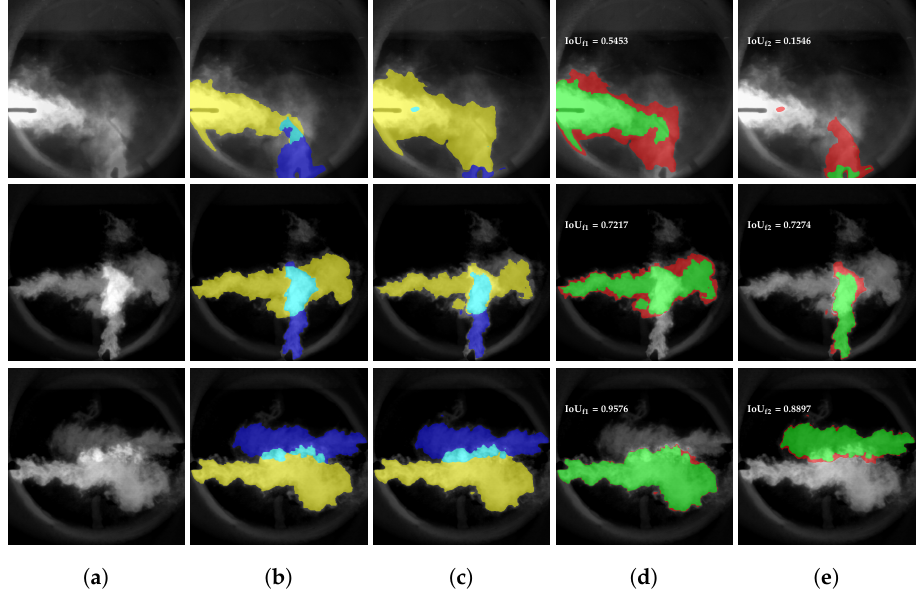
Figure 6. Gallery of instance flame segmentation with CNNs. From top to bottom, the figure shows different image series with increasing IoU f scores at our evaluation. ( a ) An original image example in our test data set. ( b ) The corresponding ground truth and ( c ) segmentation inference with a CNN. The segmentation in the upper two series have been obtained with DeepLabv3+ Inc.-RN. whereas the series at the bottom is produced with DeepLabv3+ RN18. ( d , e ) Vsualizations of the differences between the ground truth and the prediction of flame 1 (d) and flame 2 (e). The green mark-up indicates matching pixels between ground truth and prediction, whereas red mark-up indicates mismatched pixels. Table 1. Inference speed of convolutional segmentation